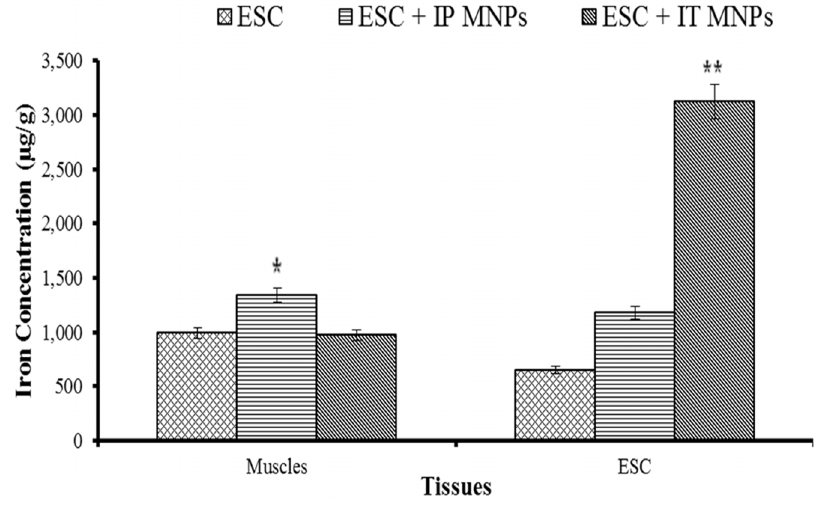
Figure 5. Bars represent distribution of iron in skeletal muscles and ESC tumor tissue of Ehrlich bearing mice groups. Asterisks indicate a statistically significant difference compared with other groups.